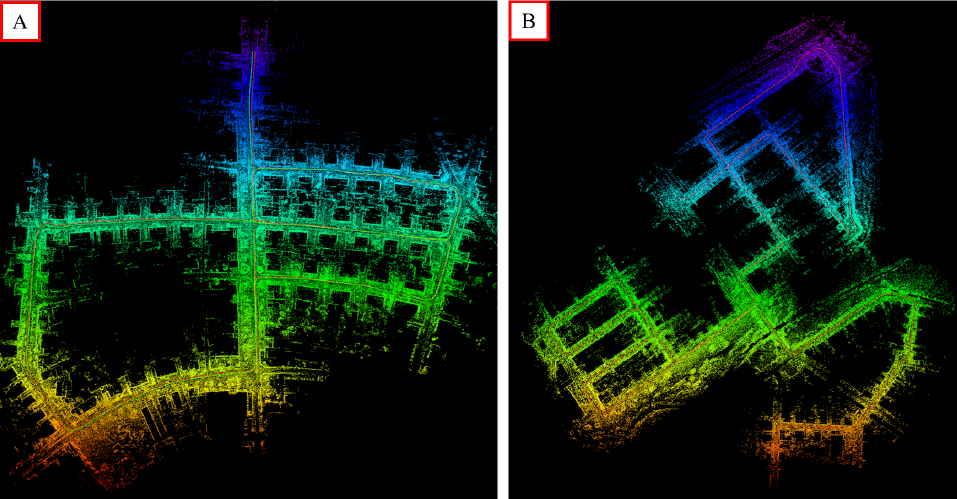
Figure 7. Examples of our approach on the public dataset KITTI. ( A , B ) represent the mapping results on sequence 05 and sequence 08, respectively.